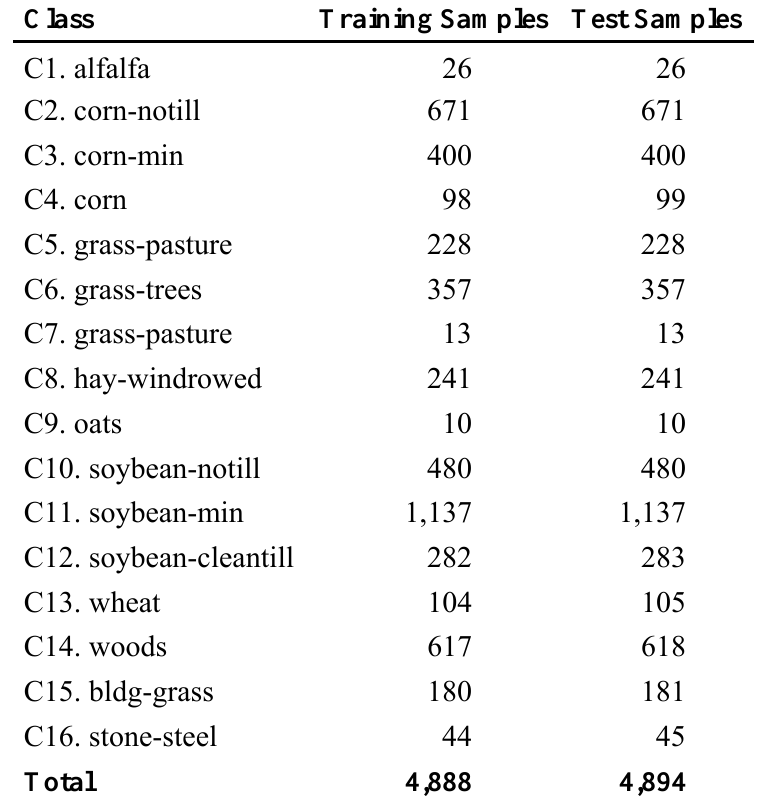
Table 1. Land-cover classes and number of training and test samples in the AVIRIS indian pines data